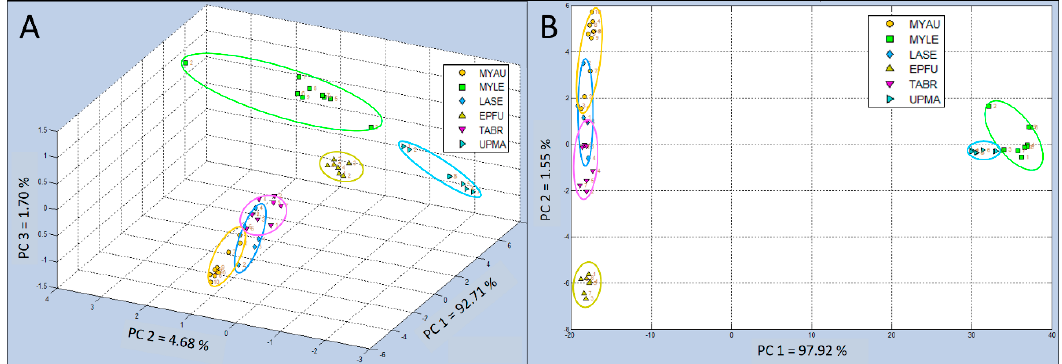
Figure 7. Comparison of C-320 e-nose VOC profiles of bat air samples from (Test Group 2) using 3-dimensional Principal Component Analysis (PCA) and 2-dimensional Canonical Discriminant Analysis Cross Validation (CDA-CV). ( A ) Single-class PCA of VOC emissions from Myotis austroripiarus (MYAU), Myotis leibii (MYLE), Lasiurus seminolus (LASE), Eptesicus fuscus (EPFU), Tadarida brasiliensis (TABR), and Ultrapure Moist Air (UPMA) control; ( B ) CDA-CV of VOC emissions from the same five bat species and control in Test Group 2.